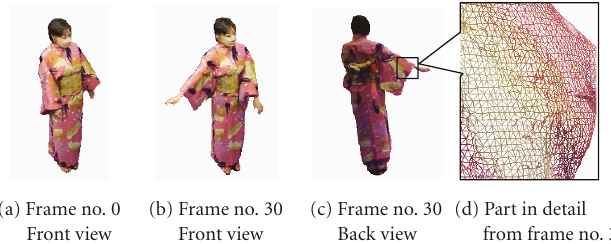
Figure 1: Sample frames in TVM; (a) a sample frame in the front view, (b) another sample frame in the front view, (c) the same frame as (b) in the back view, (d) part of the frame in (c).